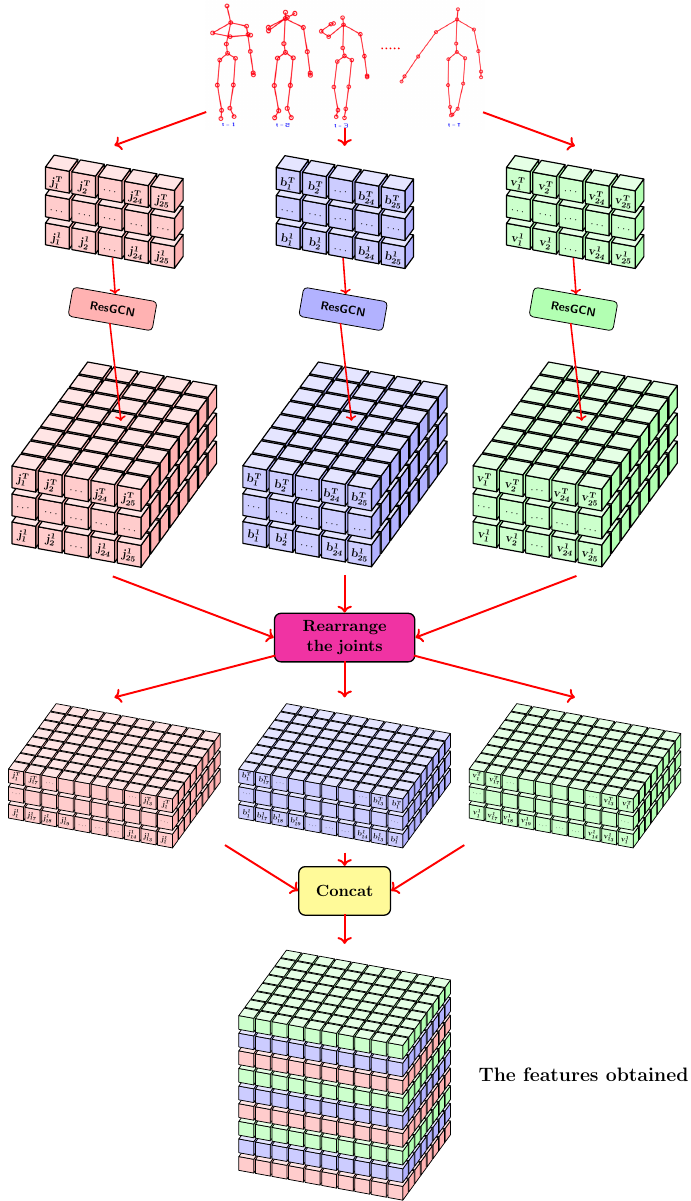
Figure 5. The pipeline that describes how to extract the features in the approach proposed by